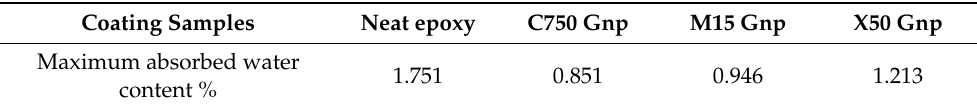
Table 3. Maximum absorbed water content % of neat epoxy, and Gnps/epoxy composite coatings when saturation was reached.